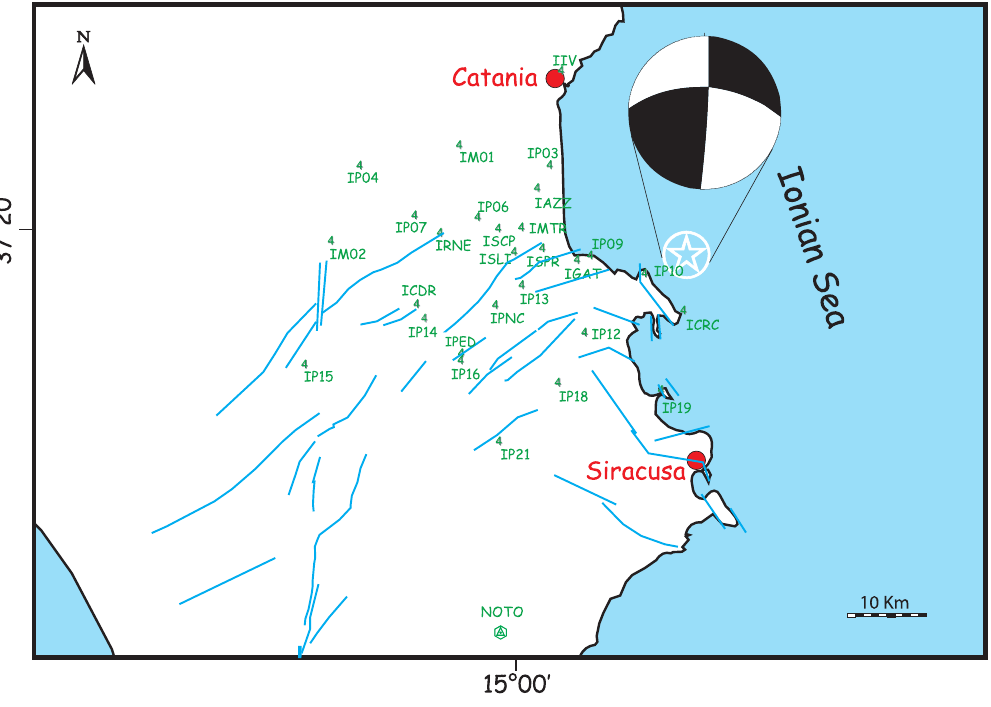
Fig. 2. The Hyblean GPS network. The GPS stations, the main tectonic lineaments of the plateau, the location of the 1990 earthquake and its focal mechanism (star and balloon) (from Amato et al. , 1995) are reported in the